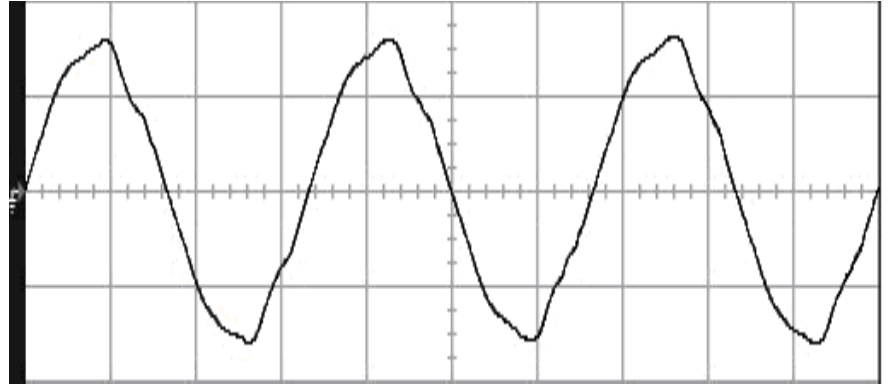
Figure 15. Experimental output voltage with conventional RSMC at nonlinear load (vertical: 100 V/div; horizontal: 5 ms/div).